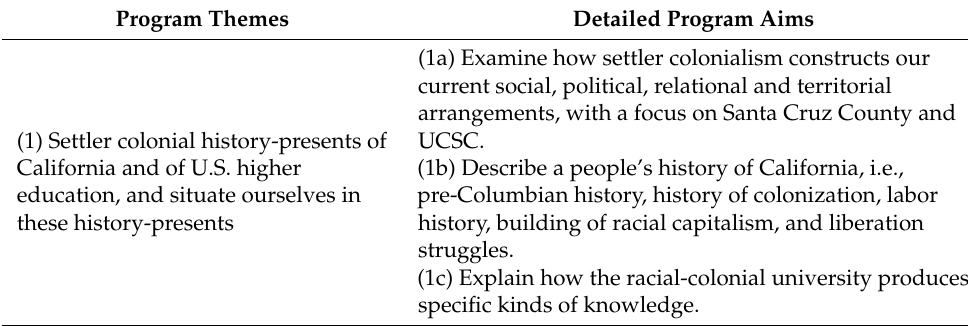
Table 3. The (H)ACER Program